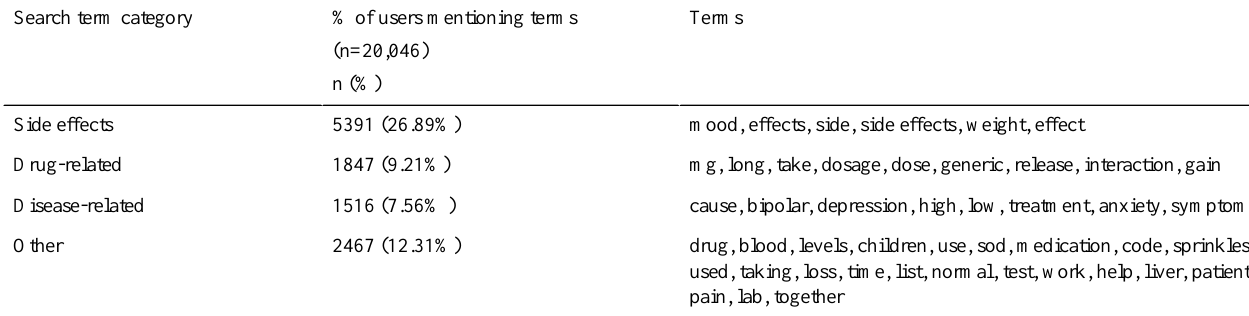
Table 1. Common MSD query terms.